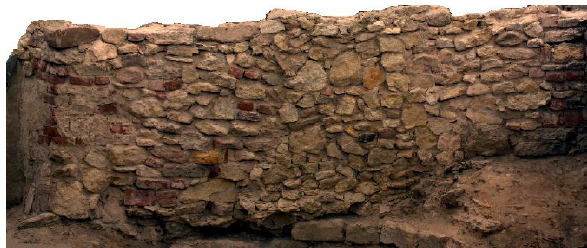
Figure 8. Orthoimage generated on the basis of DOM from stereogram